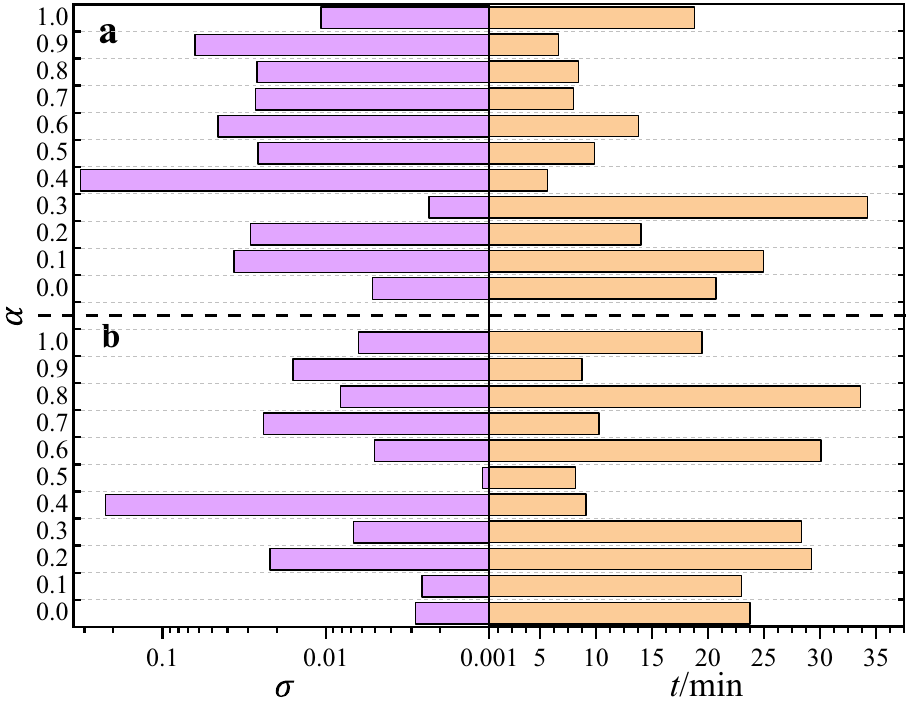
0 denotes simple random ( 1 α) ratio, where α = : − 0 denotes simple LHS ( 1 α) ratio, where α = : −